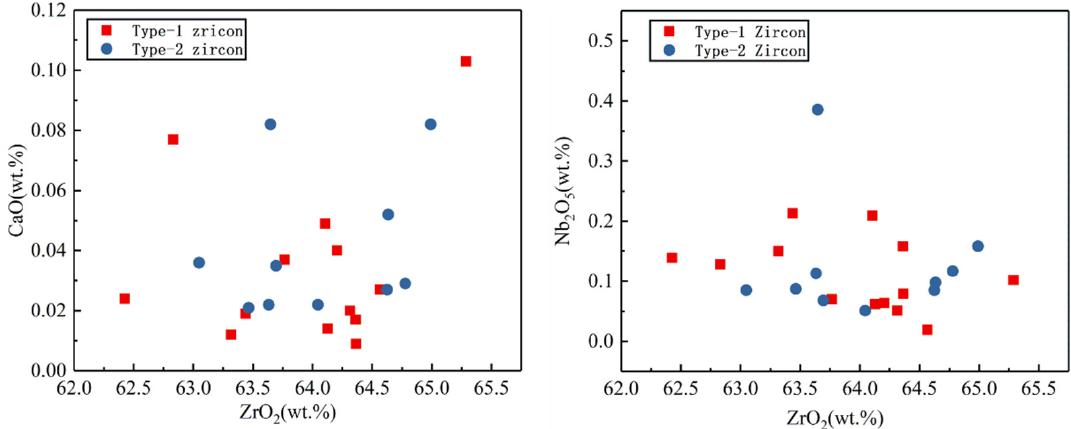
Figure 6. Major element compositions of zircon in the Shuangshan nepheline syenite as a function of the ZrO 2 (wt.%) concentration: ( right ) Nb 2 O 5 and ( left ) CaO.